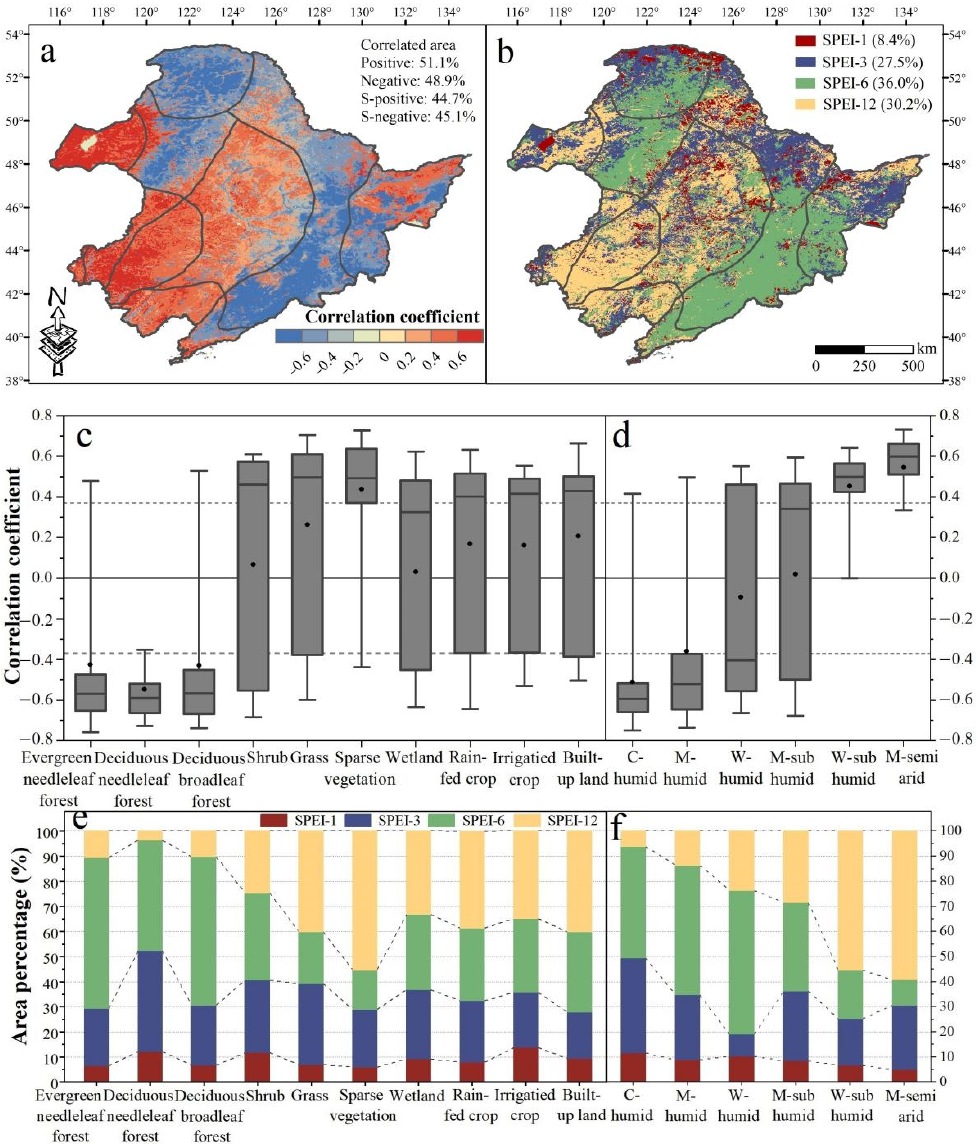
Figure 5. Spatial distribution of the maximum absolute value of correlation coefficients between NDVI and multi time scales SPEI (RNDVI-SPEIs) during the growing season (April–October) over the last three decades ( a ), the spatial distribution of the corresponding time scale of RNDVI-SPEIs during the growing season over the last three decades ( b ), the statistical distributions of RNDVI-SPEI for different land cover types ( c ) and climate regions ( d ), and the area percentage occupied by each time scale corresponding to RNDVI-SPEIs for different land cover types ( e ) and climate regions ( f ). S-in ( a ) is the abbreviation for significant. The maximum and minimum extents of the grey boxes in ( c , d ) indicate the 25th and 75th percentiles, the line and dot in each box indicate the median and mean, the whiskers represent the 5th and 95th percentiles, respectively, and the dotted lines indicate significant Pearson correlations with p < 0.05.